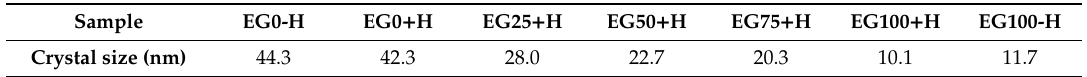
Table 1. Crystal sizes of the different CdS samples.